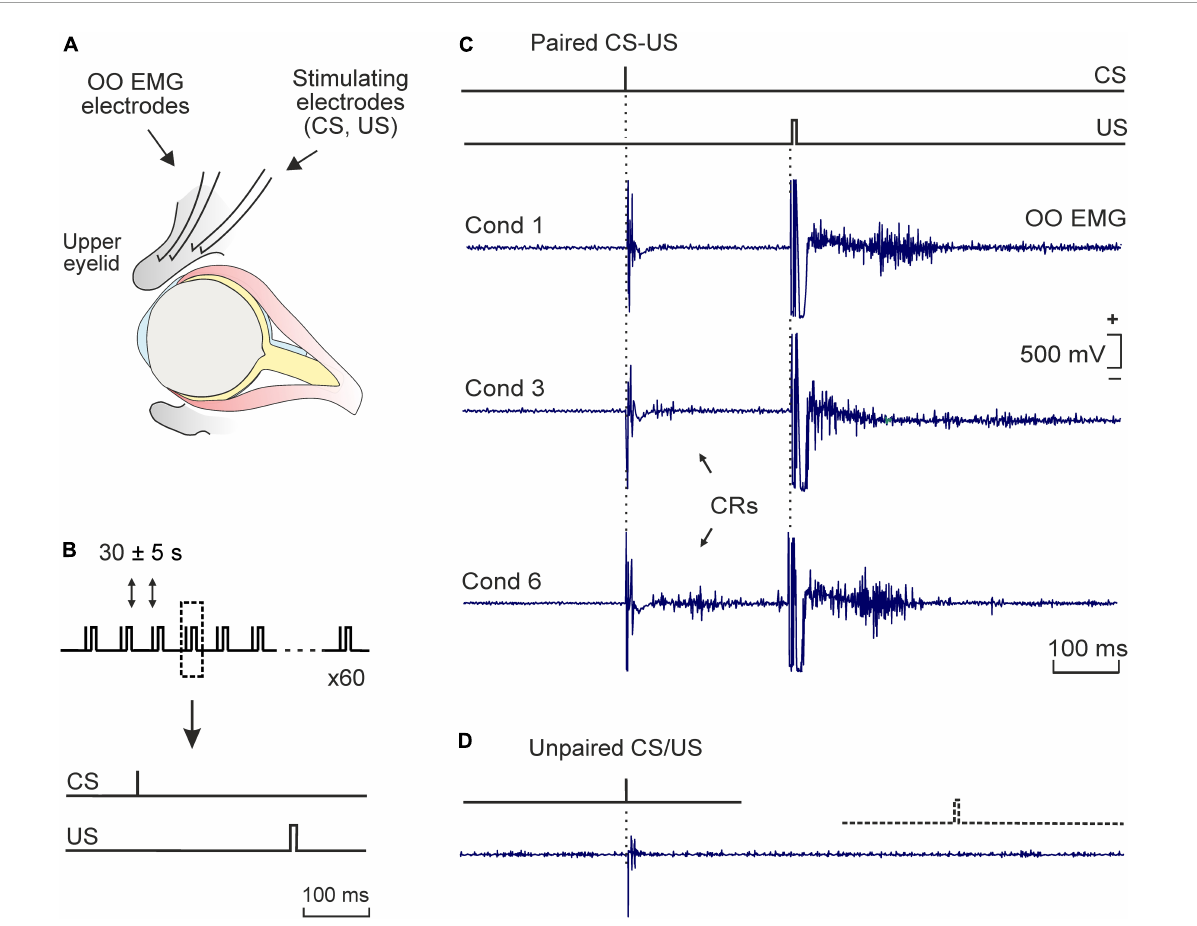
FIGURE1 Experimental design. (A) Bipolar hook electrodes were implanted on the right supraorbital nerve for electrical stimulation of this sensory nerve. The electromyographic activity of the ipsilateral orbicularis oculi muscle [orbicularis oculi (OO) electromyographic (EMG)] was also recorded. (B) Each conditioning session consisted of 6 blocks comprising 10 trails per block. The conditioned (CS) and unconditioned stimuli (US) consisted of square, cathodic pulses presented to the supraorbital nerve, lasting 0.05 ms (1.5X threshold) and 0.5 ms (3X threshold), respectively. The CS was followed by the US with an interval of 250 ms. The CS was presented alone the first trial of each block. (C) Representative examples of OO EMG profiles of eyelid responses (in mV) recorded during the 1st, 3rd, and 6th conditioning sessions (cond 1, 3, and 6). Conditioned responses (CRs) are indicated by arrows. (D) A typical eyelid response collected during pseudo-conditioning (i.e., unpaired presentation of the CS and the US). Calibration in panel (C) also applies to panel (D)